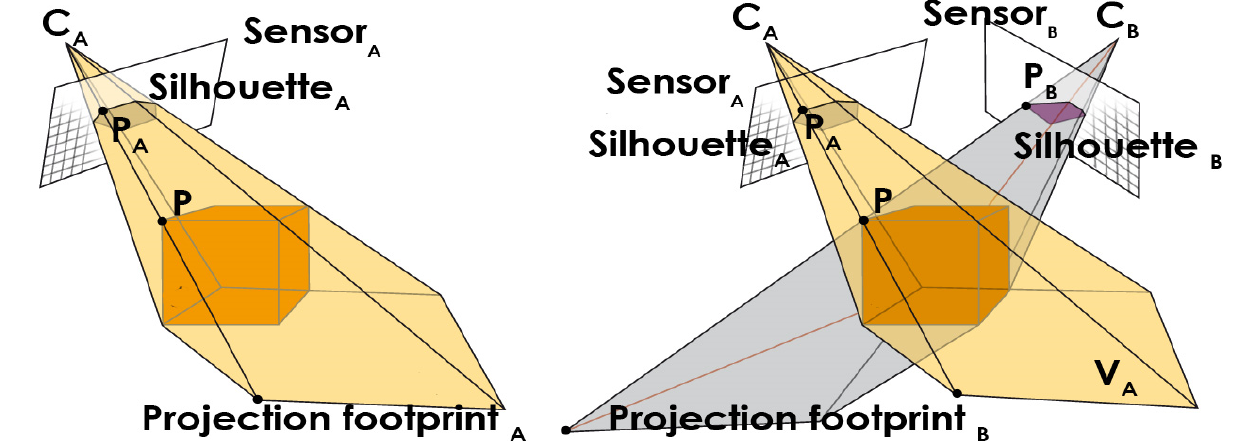
Figure 2. Left: visual cone from a single point of view. Right: intersection of multiple cones on a three dimensional